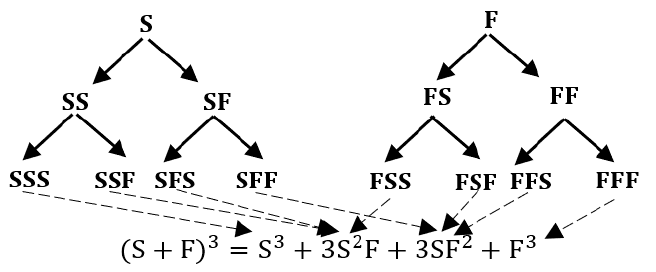
Figure 7. Arbuthnot’s binomial phenomenon reasoning (adapted from [44]).